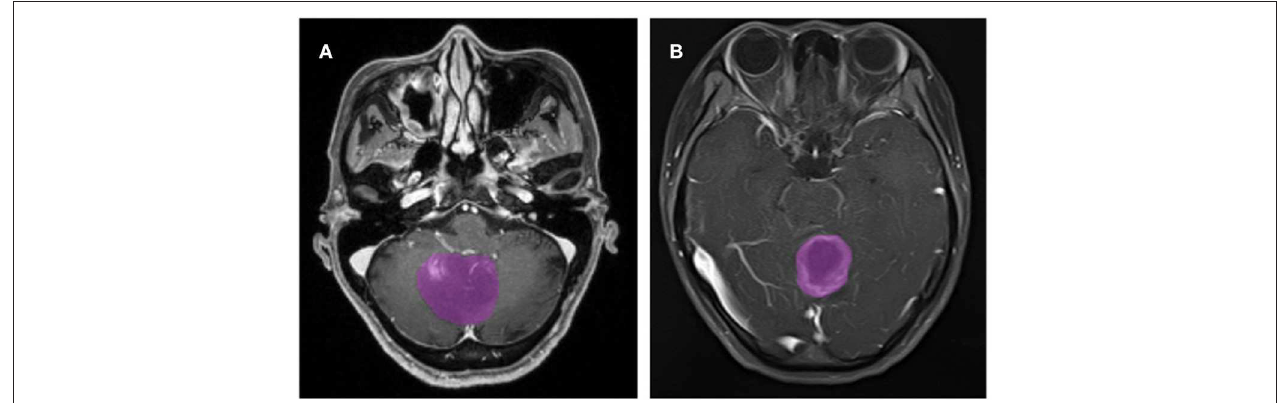
FIGURE 2 | Examples of two cases from the contrast-enhanced MR images in patients with glioblastoma and ANA. (A) Contrast-enhanced images with ANA, (B) contrast-enhanced images with glioblastoma. ANA, Anaplastic astrocytoma. TABLE 1 | Discrimination between glioblastoma and ANA. Training Validation Sensitivity